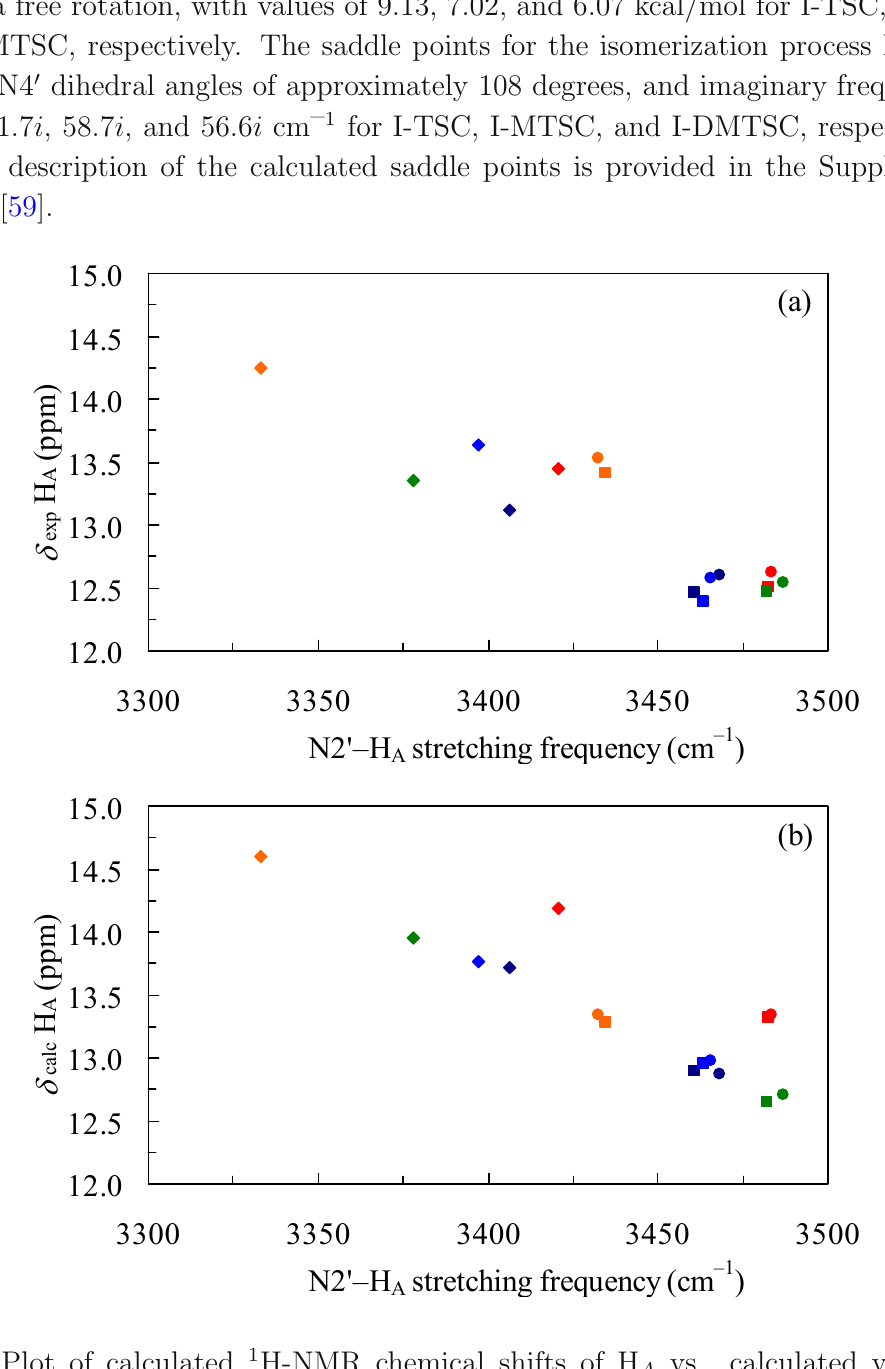
Fig. 11 Plot of calculated 1 H-NMR chemical shifts of H A vs. calculated vibrational frequency for the N2 (cid:2) –H A